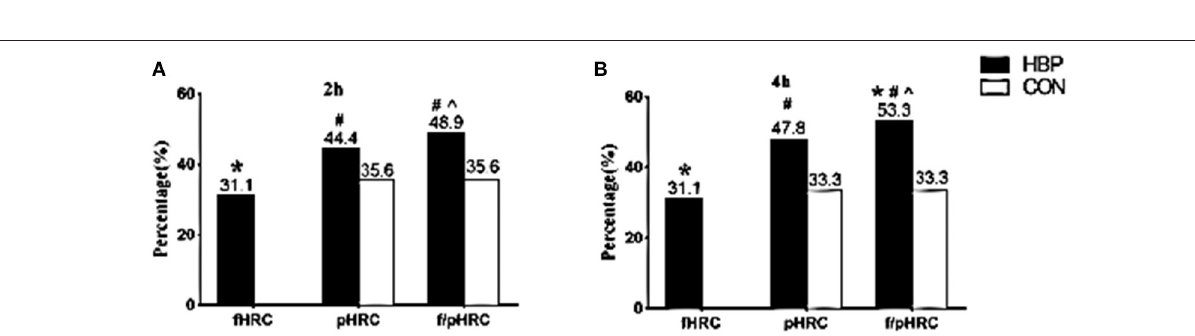
subjects visit the medical services at the postprandial